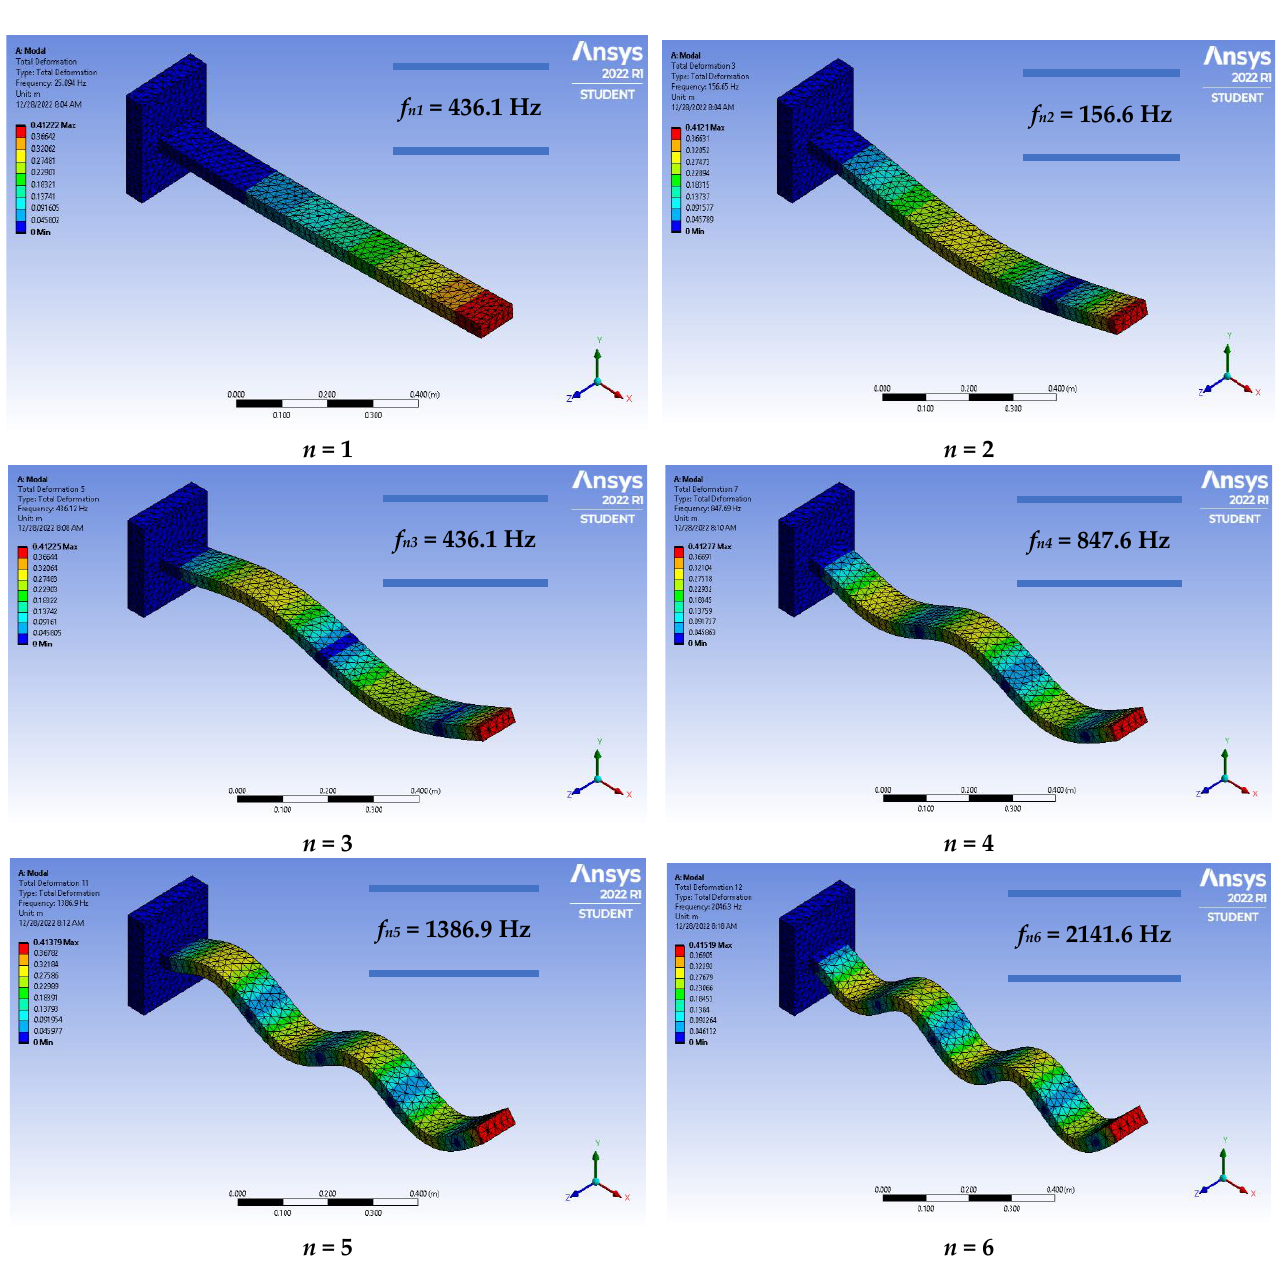
Figure 5. First six mode shapes ( n = 1~6) of transverse vibration of a cantilever beam.